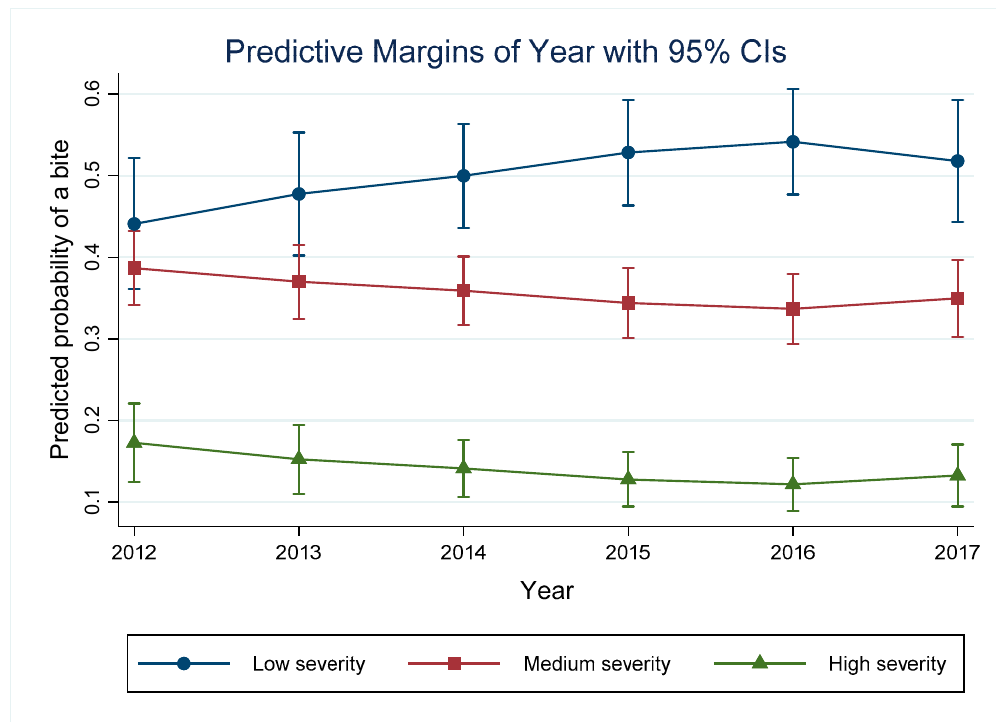
Figure 5. Predictive margins for the different severity incidents depending on the victim age category and controlling for other variables in the model.